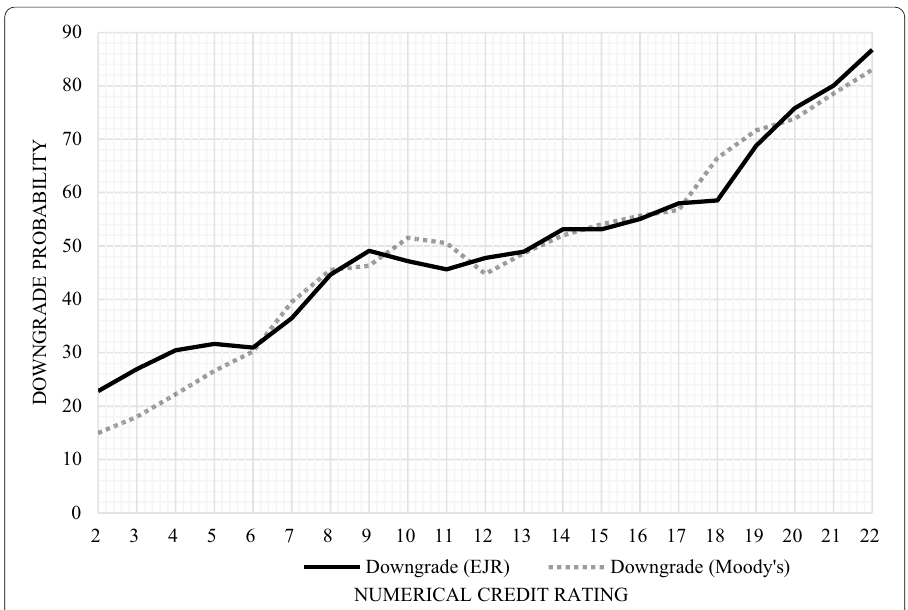
Fig. 3 Downgrade probability plots for numerical credit ratings assigned by EJR and Moody’s, from 2011 to